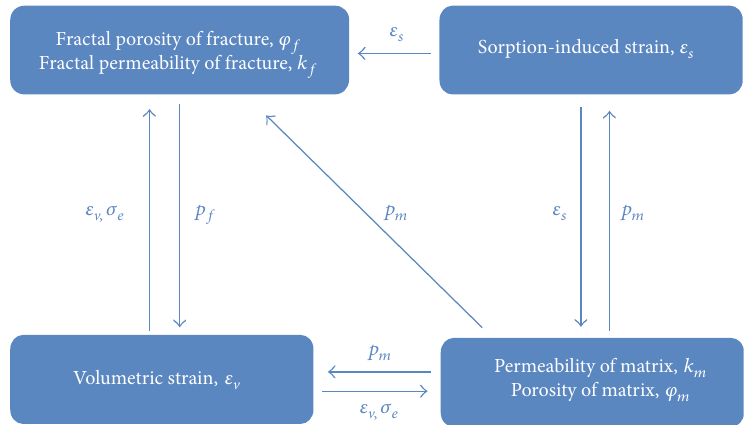
Figure 1: Coupling relation of the fractal